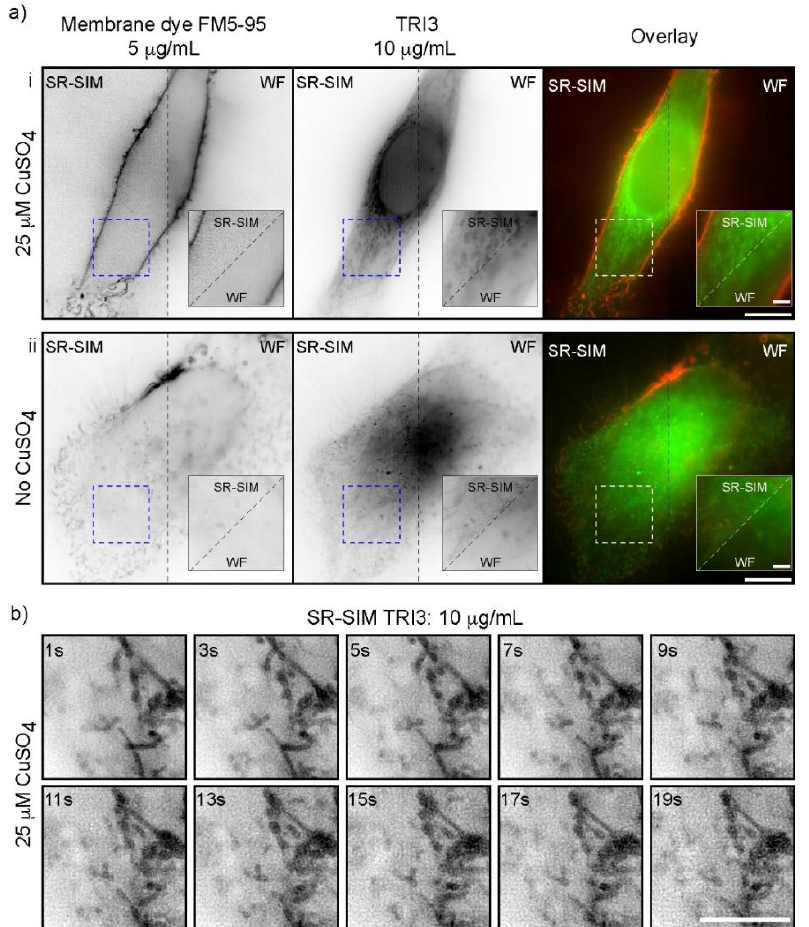
Figure 6. ( a ) SR-SIM and WF live-cell imaging of HeLa cells stained with 10 μg/mL of 4 and 5 μg/mL FM5-95 membrane dye (5 min in DMEM) with (i) or without (ii) 25 μM CuSO 4 . Insets are zoomed highlights of the regions defined by the dashed squares. Scale bars are 10 μm in the full-sized images and 2 μm in the insets. ( b ) SR-SIM continuous time-lapse at 1 super-resolution frame per second (20 s total imaging time) of HeLa cells stained with 10 μg/mL of 4 (for 5 min in DMEM) showing mitochondrial dynamics are not affected in the presence of 4 . Scale bars are 5 μm.